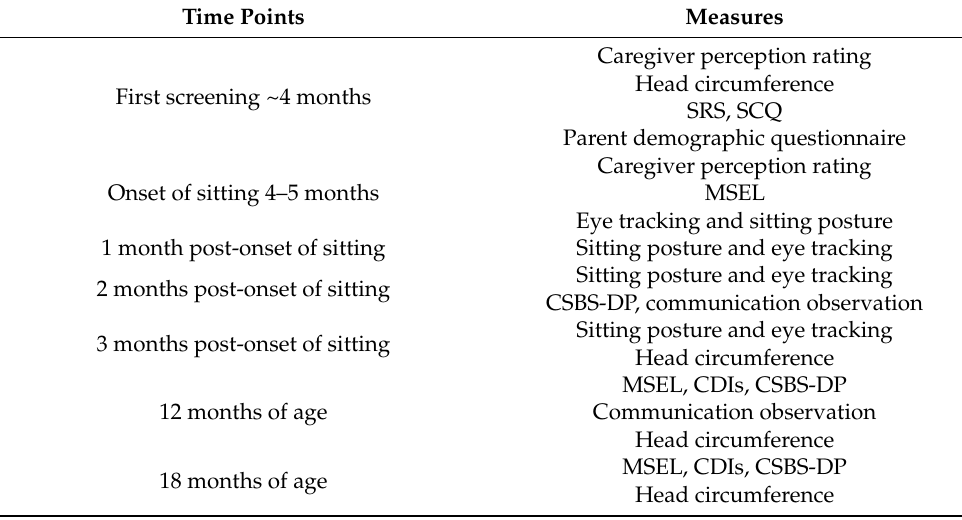
Table 3. Flow diagram of data collection